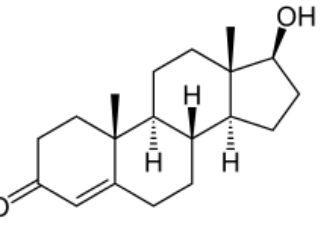
Figure 36. Chemical structure of testosterone. Formula: C 19 H 28 O 2.